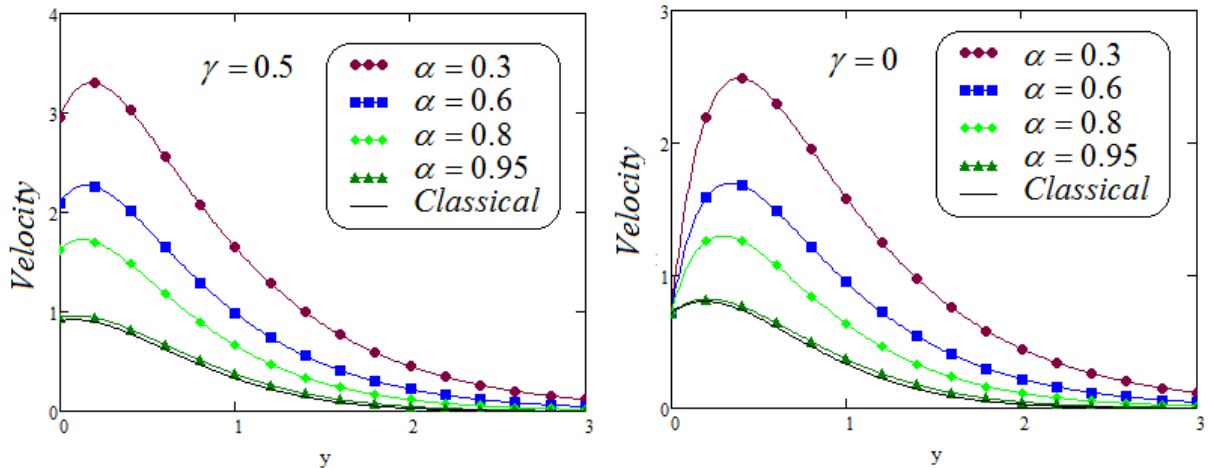
Figure 18. Velocity comparison for varied values of α with and without slip effect γ when f ( t ) = sint , t = 1.5, β = 0.3, Gr = 3.5, λ 1 = 0.6, P r = 0.71, λ 2 = 0.2, M =